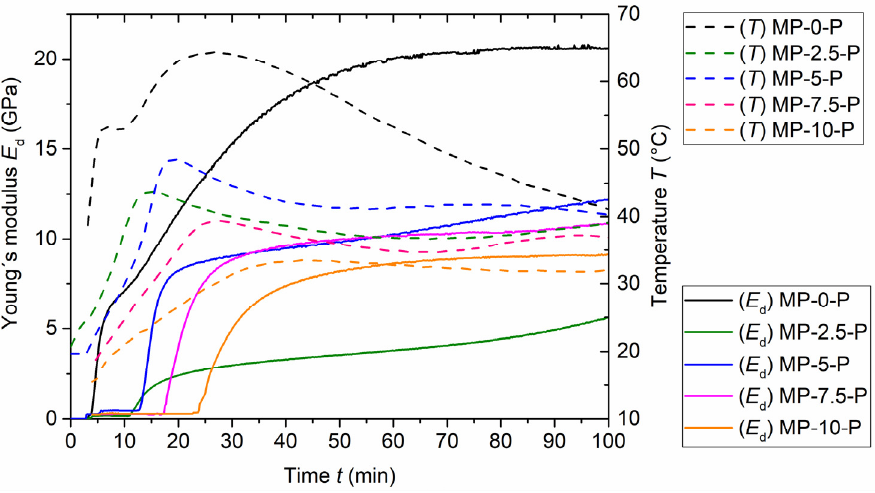
Figure 3. Development of the dynamic Young’s modulus of fresh MKPC pastes, duration 100 min.